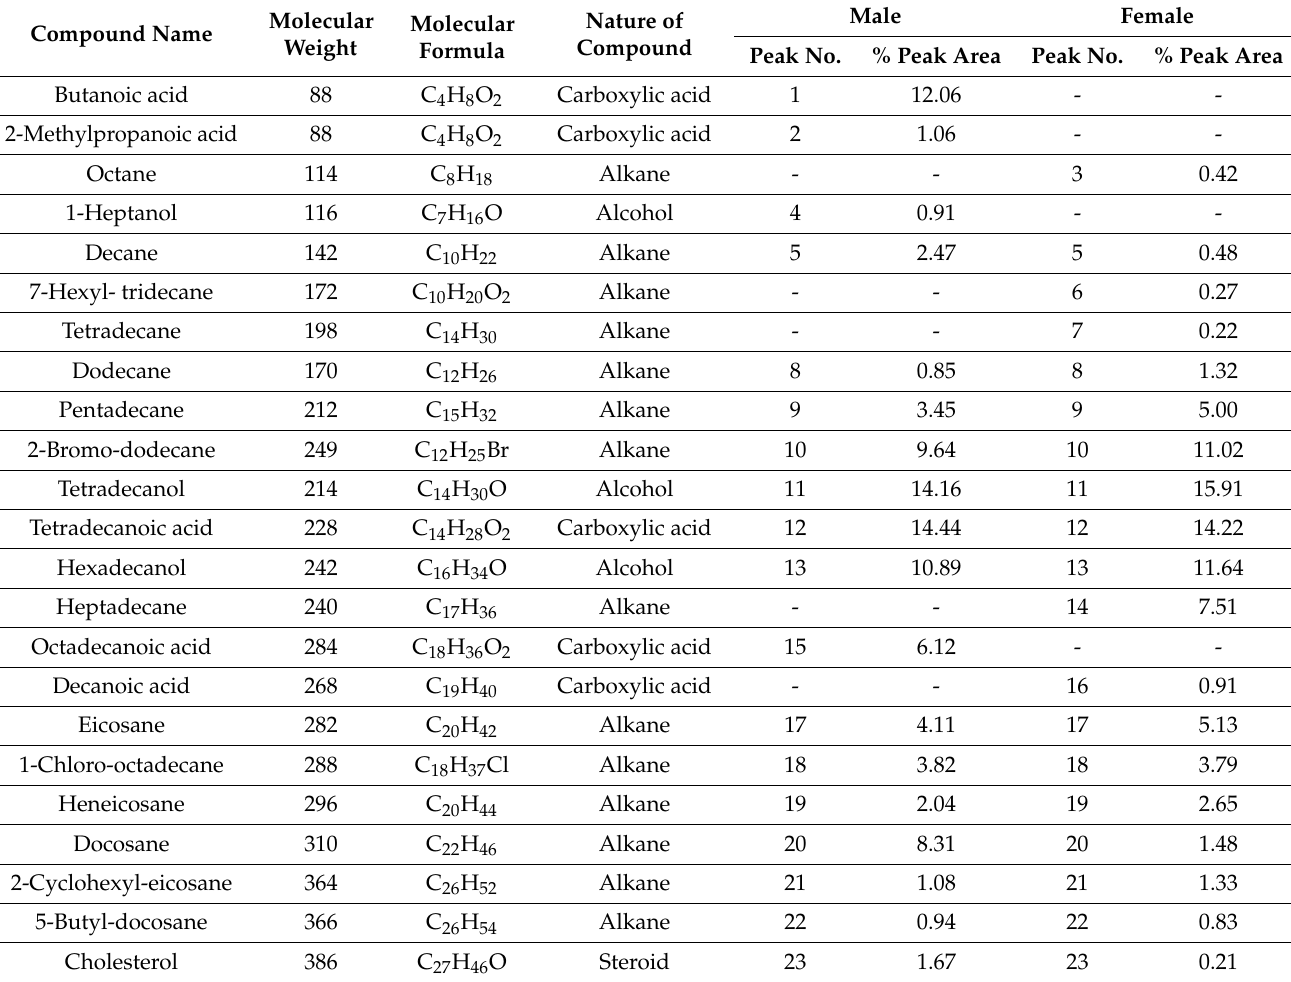
Table 1. The volatile compounds in the interdigital gland secretion of the male and female Vem- bur